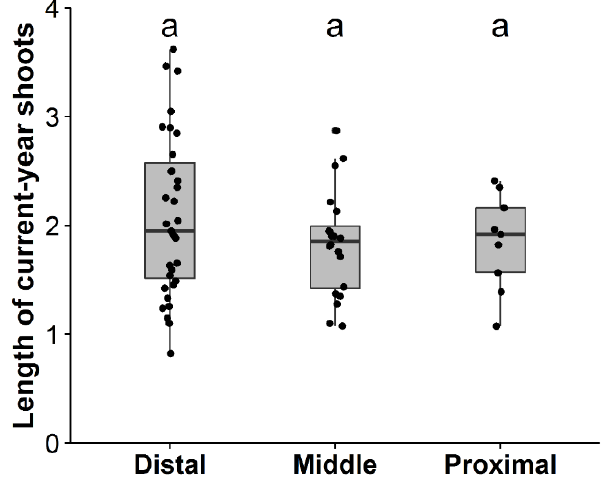
Figure 4. Comparison between the secondary branch positions of the mean length of current-year shoots. Closed circles show the data, but the data fluctuated randomly in horizontal directions. The letters indicate that the differences between groups were not significant ( p < 0.05, Tukey honest significant difference test). Length of a box indicates the interquartile range, where the horizontal lines inside each box represent the median, and the bottom and top of the box represent the first and third quartiles, respectively. The lower and upper whiskers show 95% confidence intervals. The closed circles outside the boxes represent outliers. The generalized linear mixed models coefficients are given in Table 3.